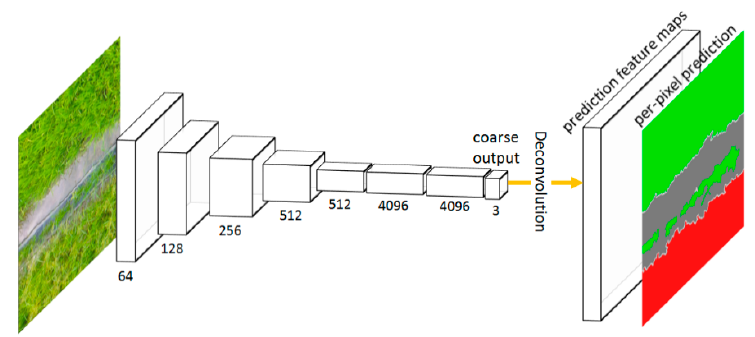
Figure 5. General architecture of an FCN.